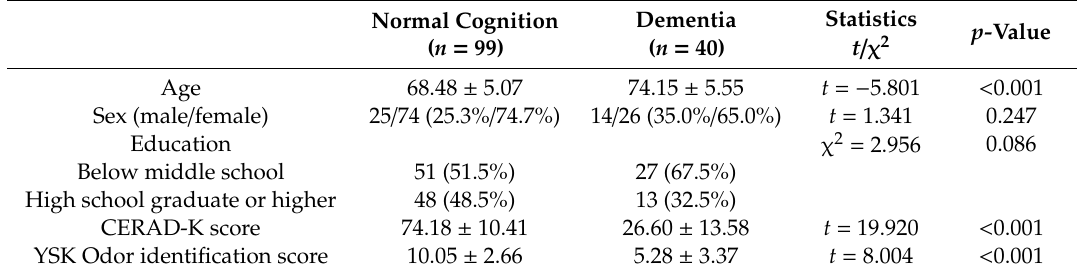
Table 1. Demographic characteristics of the study population ( n =